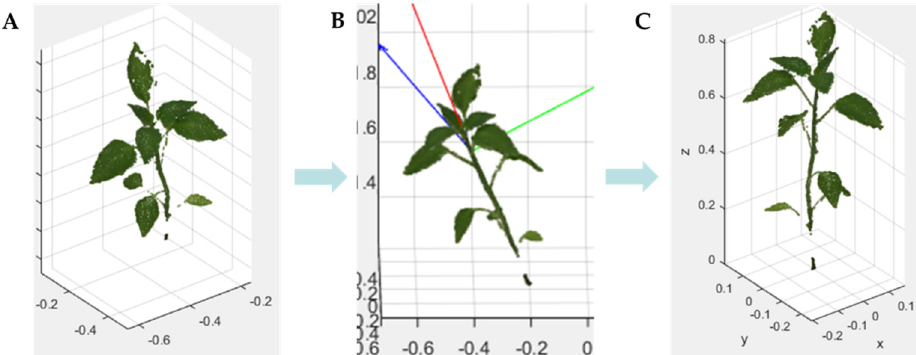
Figure 10. Coordinate transformation: ( A ) Original 3D image; ( B ) PCA performed on a 3D crop image; and ( C ) standardization of coordinate system through Euler angle transformation.